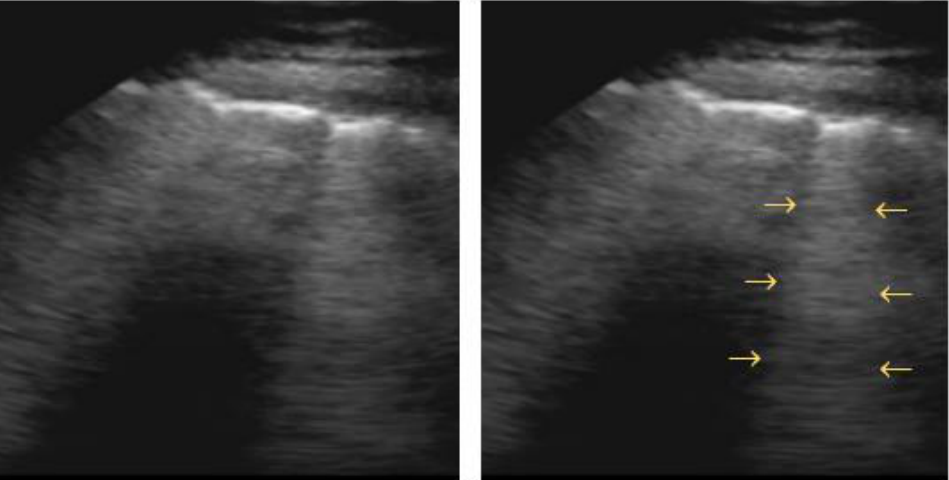
Figure 4. B-line: arrows point to vertical hyperechoic “comet-tail” artifacts arising from the pleural line and moving along with lung sliding.